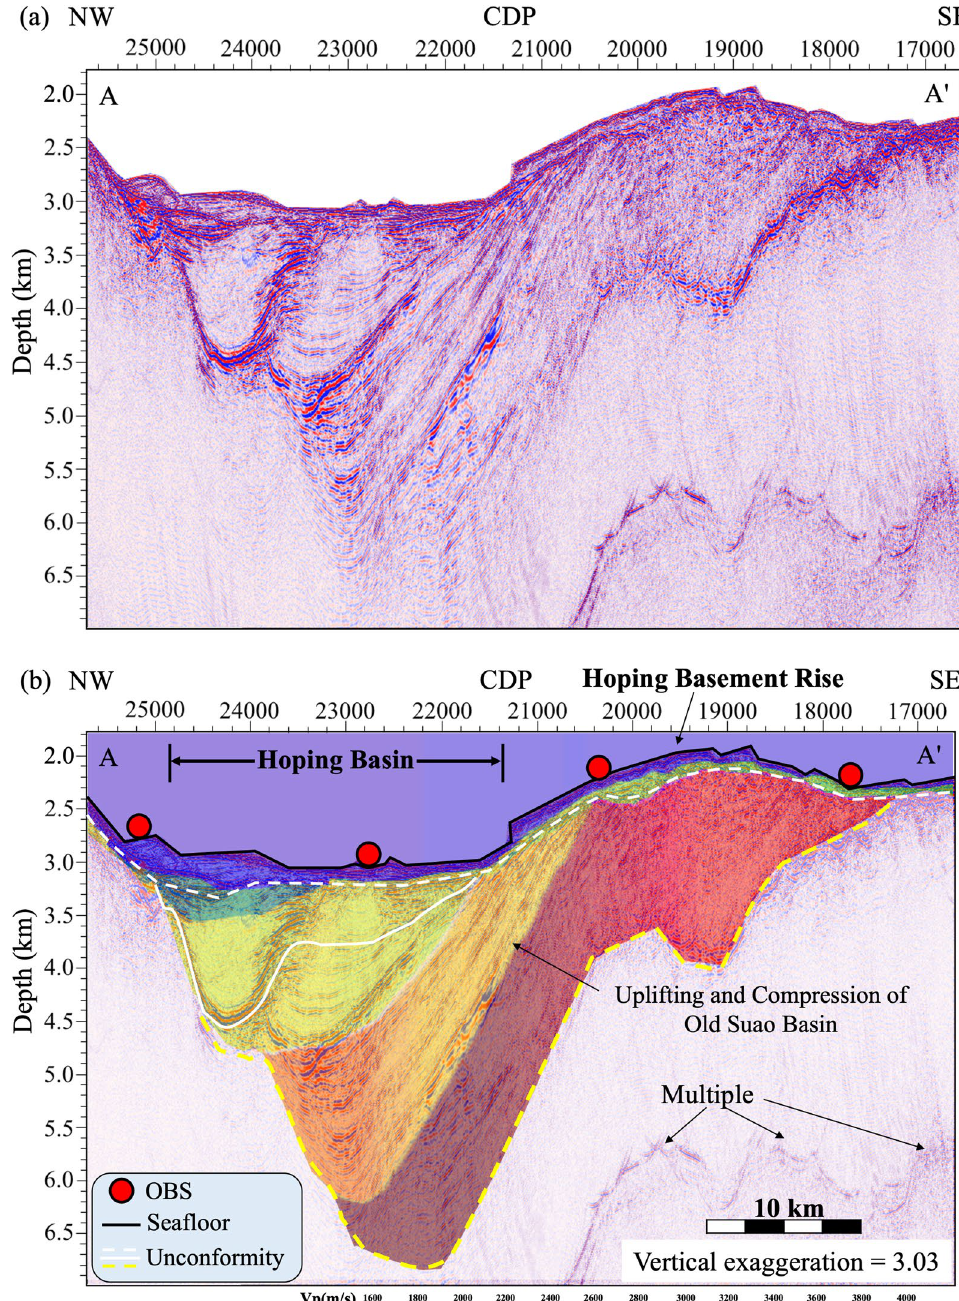
Fig. 3 a The uninterpreted PSDM section and b the horizontal velocity model is superimposed on the PSDM section with interpretations across the Hoping Basin along Line AA’ (Fig. 2) of